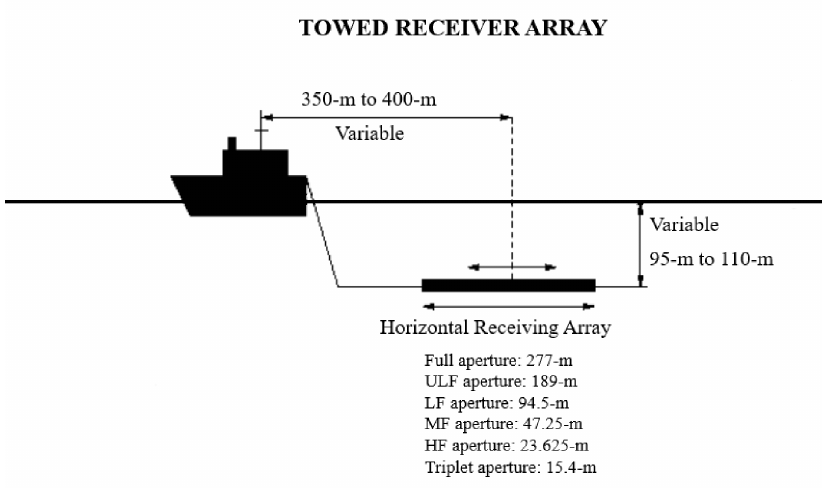
Figure 2. OAWRS receiving array system used during the Gulf of Maine 2006 Experiment [7]. The towed horizontal receiving array and OAWRS vertical source array were separately deployed from two research vessels for bistatic